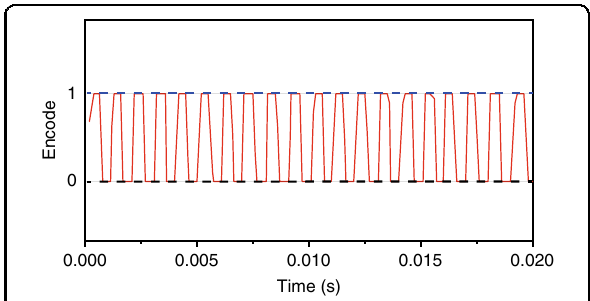
Fig. 3 Channel-security detection using single photons. The collected waveform (red) corresponding to the change with the generated SFG photon number is accumulated every 0.02 s while including a bin width of 300 ps. Codes “ 0 ” and “ 1 ” are indicated by the dotted blue and black lines,